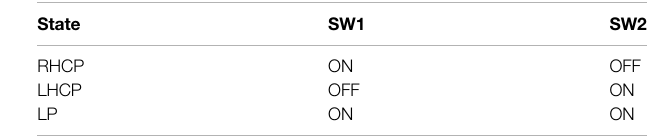
TABLE 2 | Different polarization